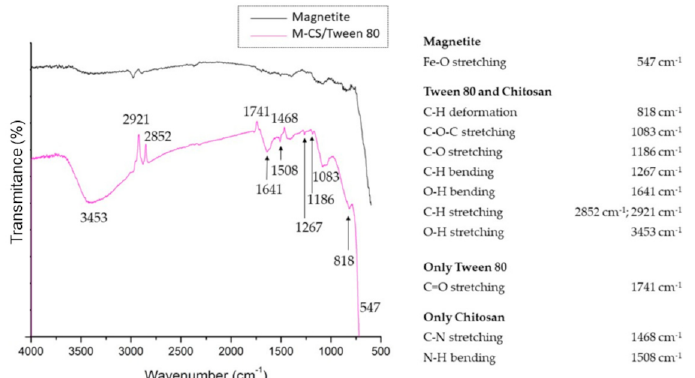
Figure 2. FTIR spectra of bare magnetite and chitosan/Tween 80 microspheres loaded with magnetite nanoparticles (M-CS/Tween